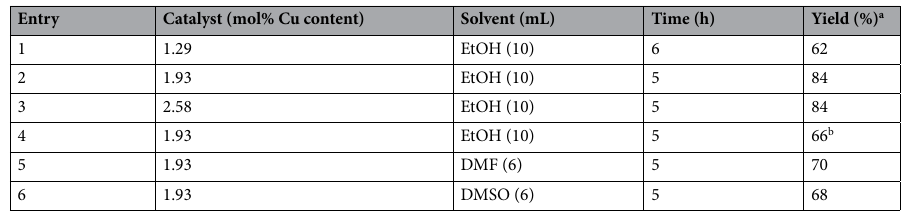
Table 1. Synthesis of 2-(4-cholorophenyl)-3-iminoisoindolin-1-one using various quantities of the catalyst in the different solvents at 25 °C under US irradiation and thermal conditions. Reaction conditions: